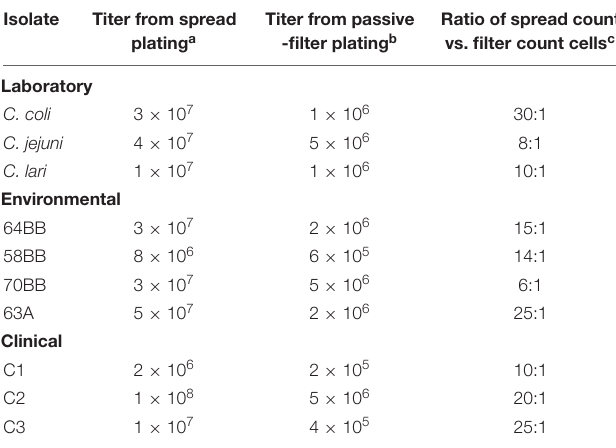
a Titers calculated from 0.1 mL of bacterial suspension dilutions plated directly onto BAP plates; b Titers calculated from 0.1 mL of the same bacterial suspension dilutions plated onto BAP-containing polycarbonate filters as described in section “Materials and Methods”; c Ratio of culturable cells calculated from spread plates vs. passive-filter